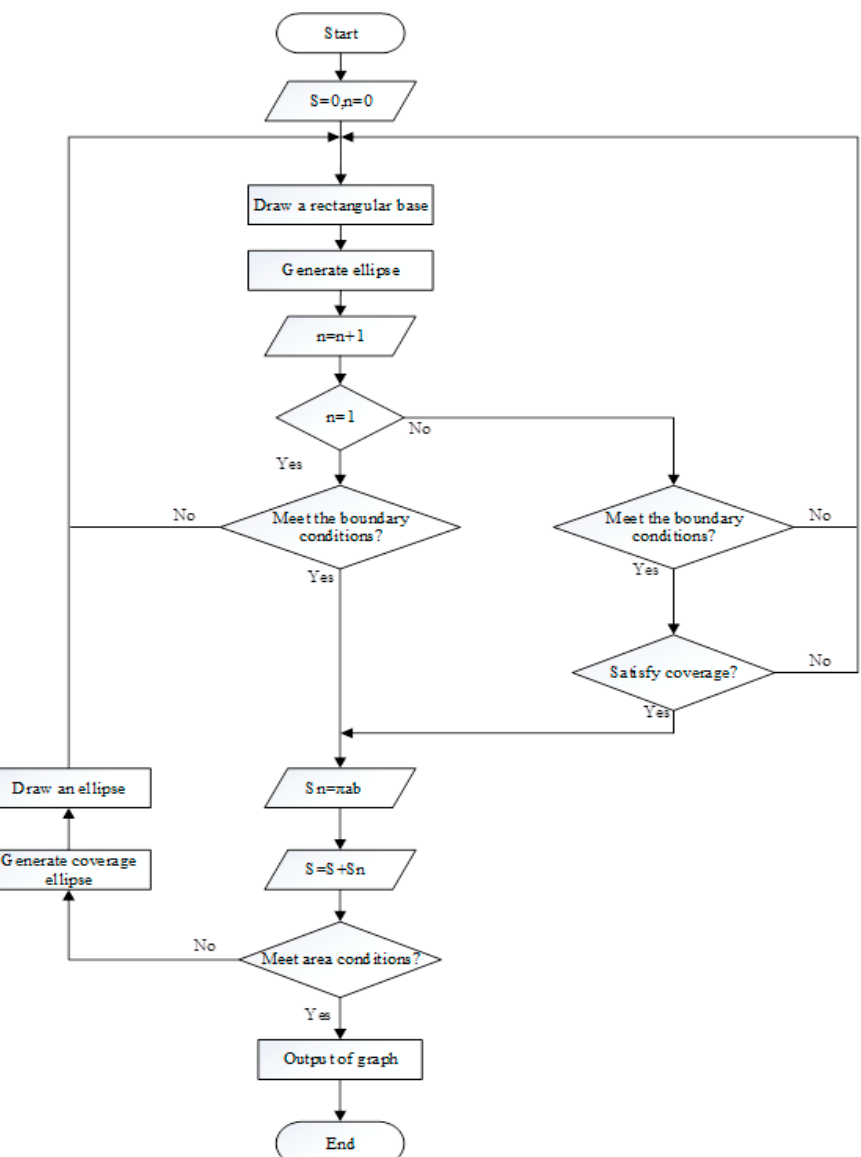
Figure 4. Flow chart of particle random distribution algorithm.